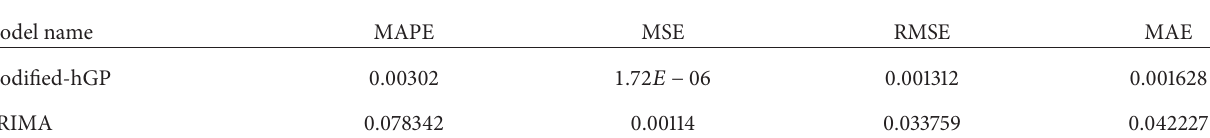
Table 13: Statistical indices in forecasting process of the modified-hGP and ARIMA model for the total number of OECD prepay mobile subscribers.